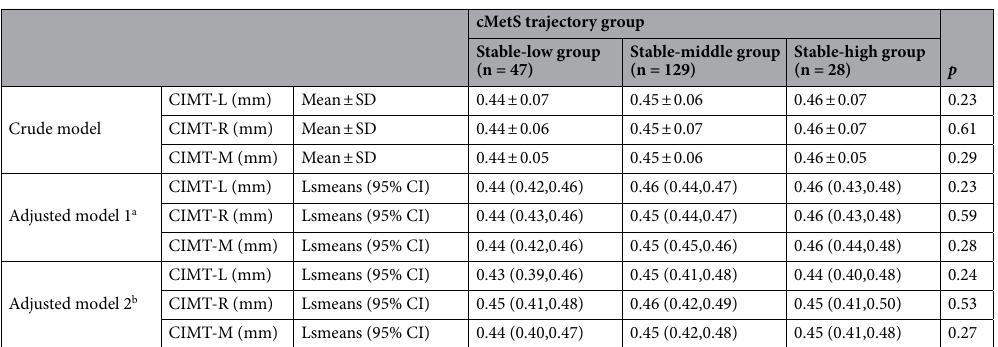
Table 3. Mean comparison of CIMT between groups of cMetS trajectories. SD, Standard deviation; LSMeans, least-squares means; cMetS, continuous metabolic syndrome score; CIMT-L, left carotid intima-media thickness; CIMT-R, right carotid intima-media thickness; CIMT-M, mean carotid intima-media thickness. a Model1 was adjusted for sex. b Model2 was adjusted for sex, age, monthly household income, parental history of disease (CVD, cardiovascular diease; DYS, dyslipidemia; HTN, hypertension; DM, diabetes mellitus.), weekly vigorous-intensity physical activity, and secondhand smoking.